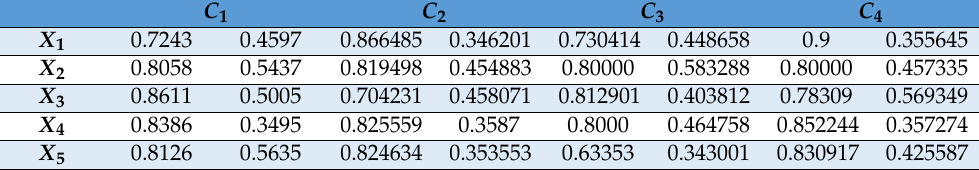
Table 11. Collective preferences using q-ROFAAG of expert’s information given in Tables 5–7. C